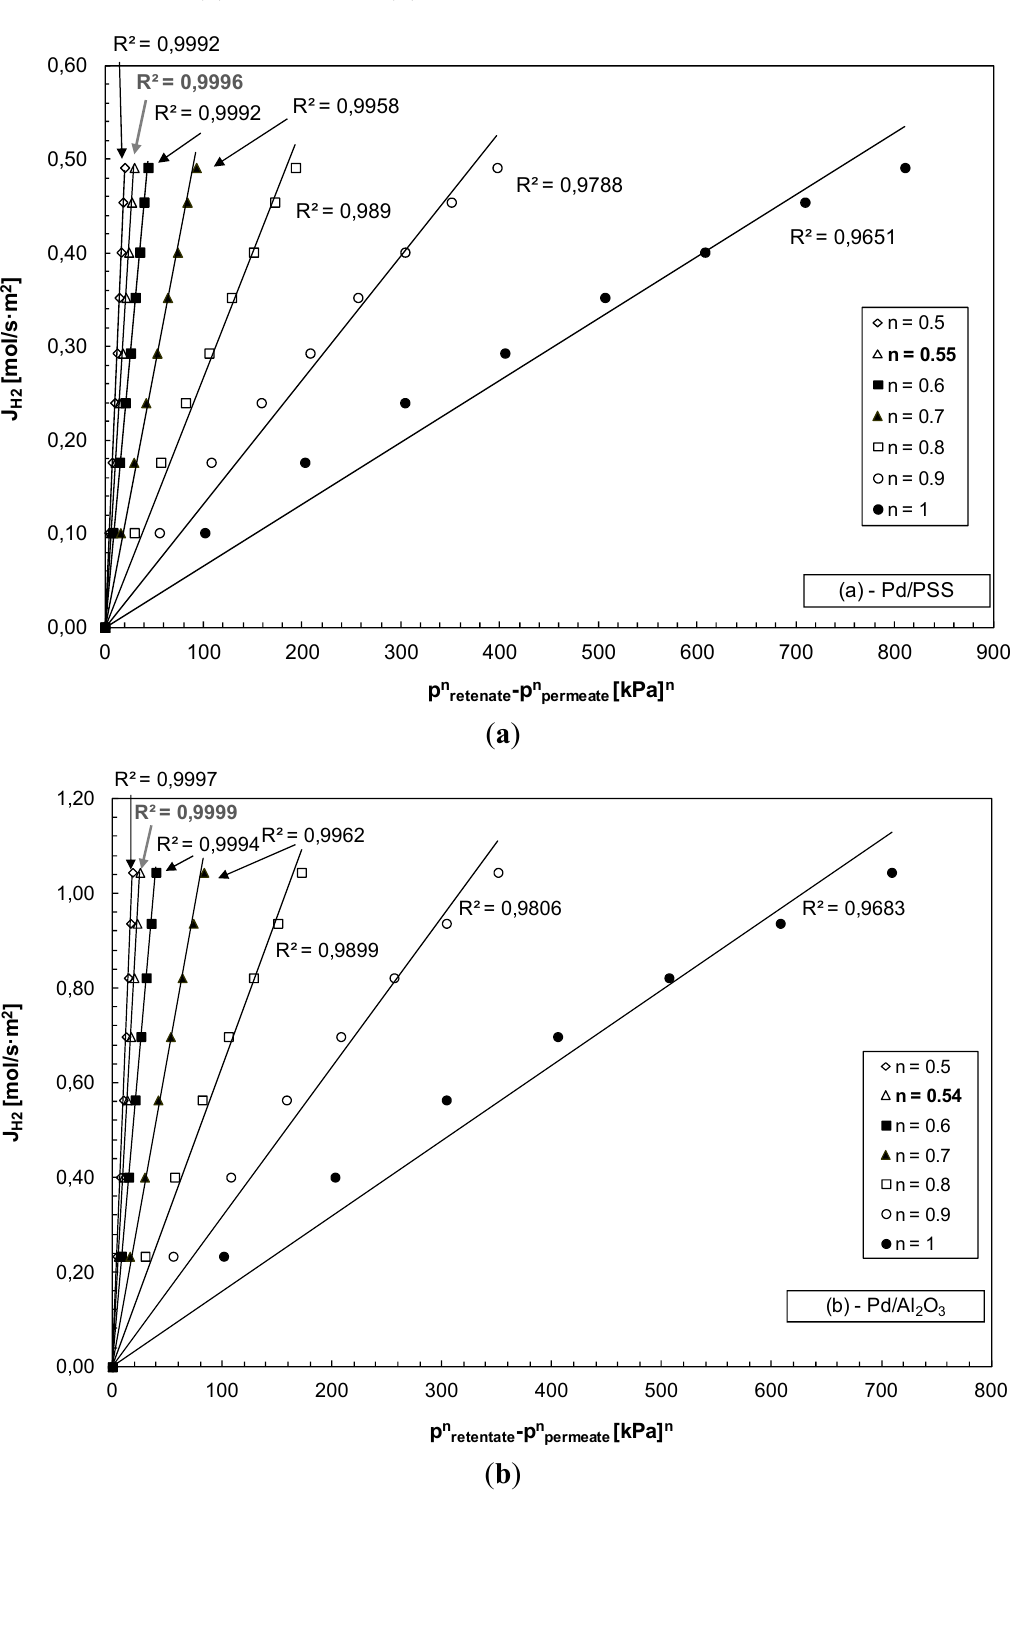
Figure 4. H permeating flux as a function of the trans-membrane pressure at different “ n ” 2 values; T = 400 °C, ( a ) Pd/PSS and ( b ) Pd/Al